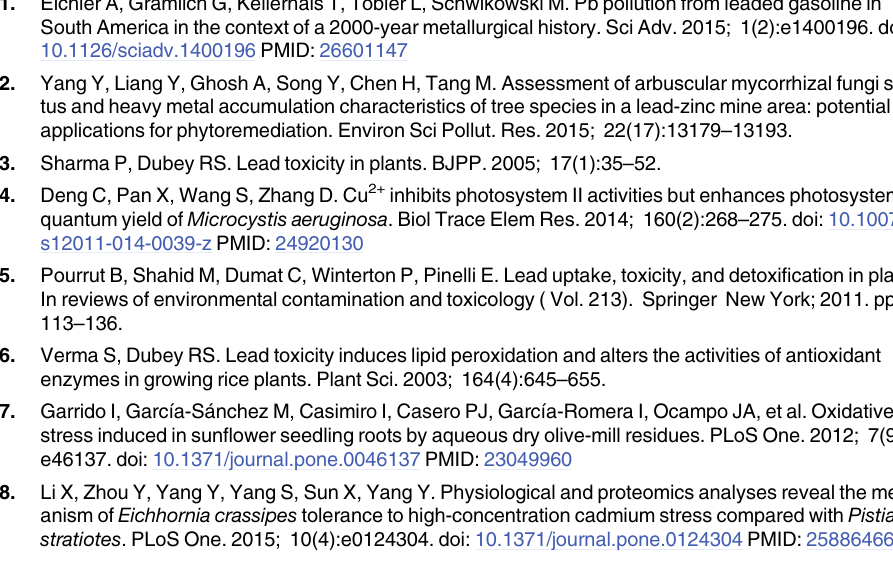
S1 Table. Multiple ANOVA comparisons of MC, Pb concentration in the leaves and roots, and the TF value of R . pseudoacacia under Pb stress and AMF inoculation treatments. S2 Table. Multiple ANOVA comparisons of Fv/Fm, F PSII, qN and qP in R . pseudoacacia leaves under Pb stress and AMF inoculation treatments. S3 Table. Multiple ANOVA comparisons of Pn, g leaves under Pb stress and AMF inoculation treatments. S4 Table. Multiple ANOVA comparisons of SOD, POD, CAT, APX, GPX and GR activities in R . pseudoacacia leaves under Pb stress and AMF inoculation treatments. S5 Table. Multiple ANOVA comparisons of H leaves under Pb stress and AMF inoculation